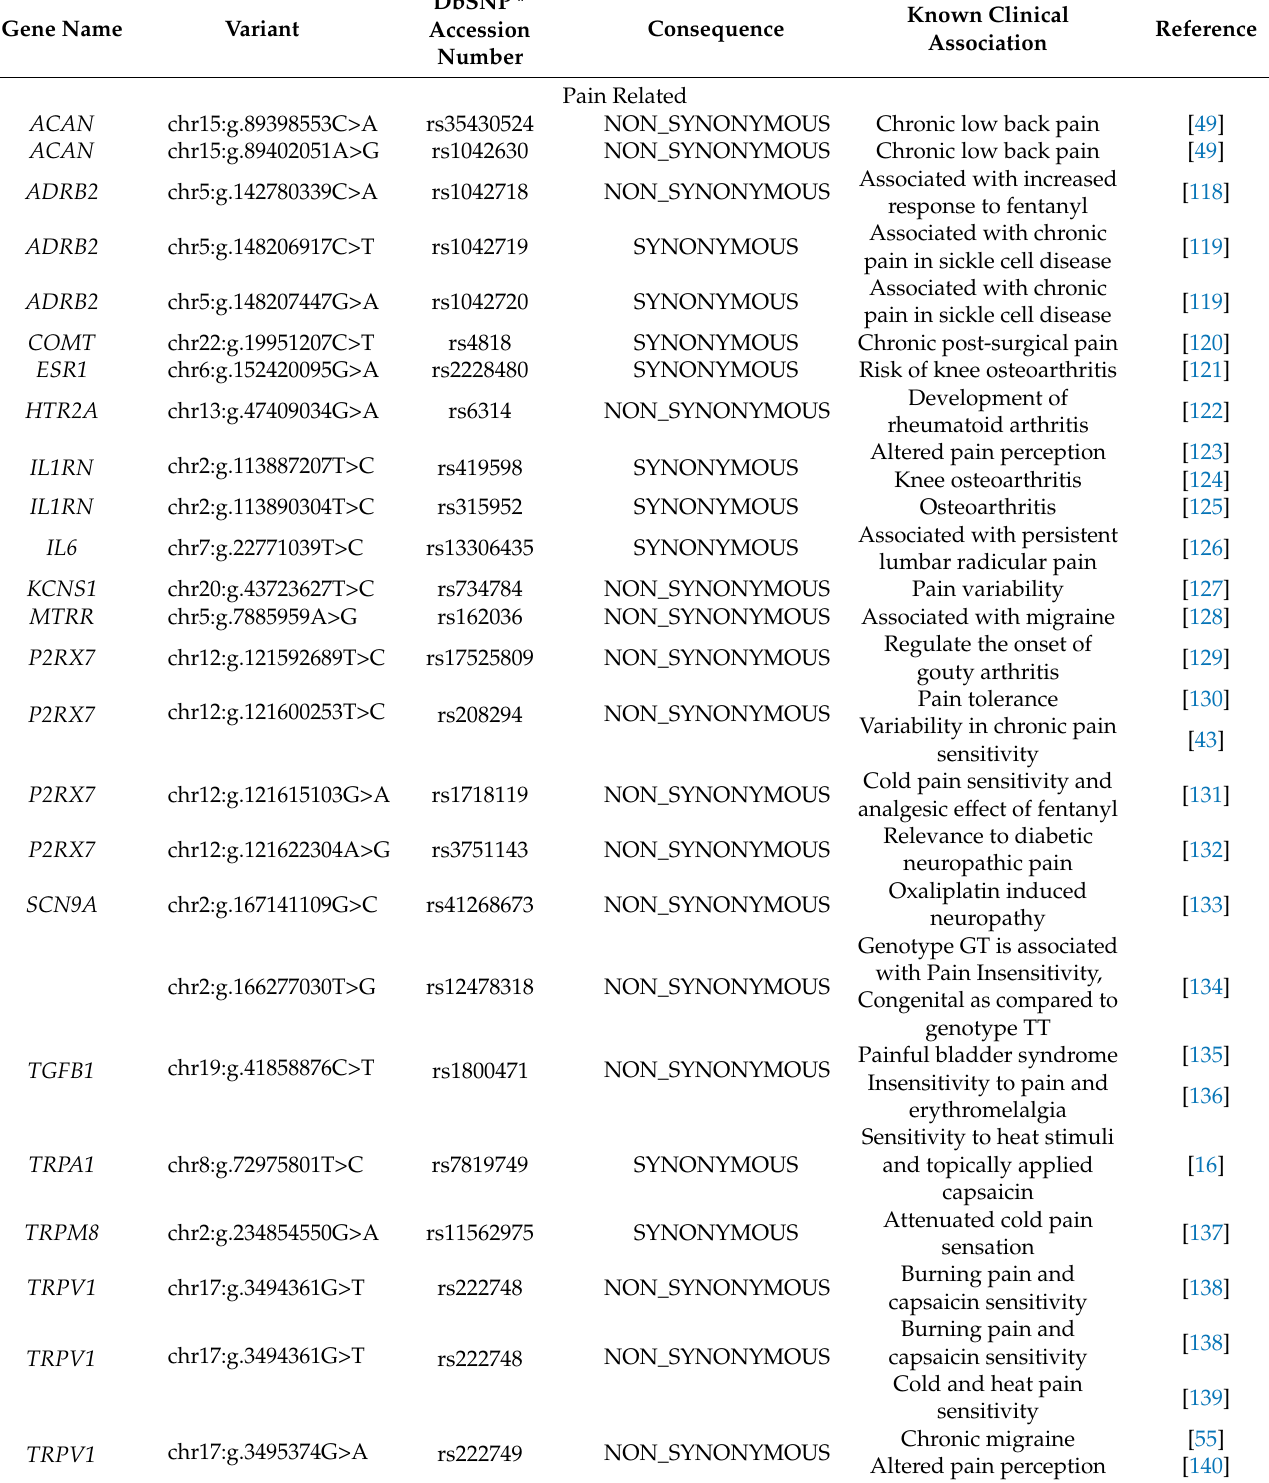
Table 2. Variants with reported clinical effects. The table provides a list of human variants in the 72 putative chronic pain genes which were found in the present random sample of 61 subjects of Caucasian ethnicity, for which clinical associations have been